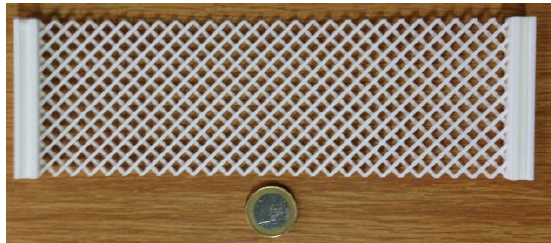
Figure 1. Example of a pantographic structure de- veloped by